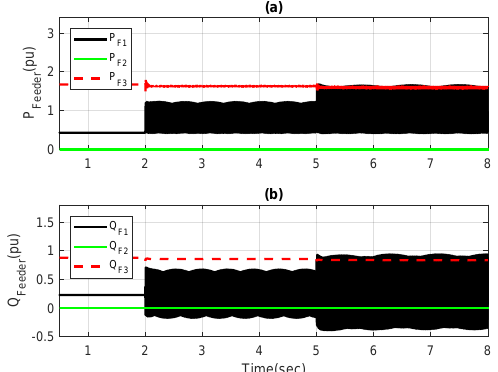
Figure 9. Unbalanced load changes in feeder F 1 ( a ) instantaneous real and ( b ) reactive power of